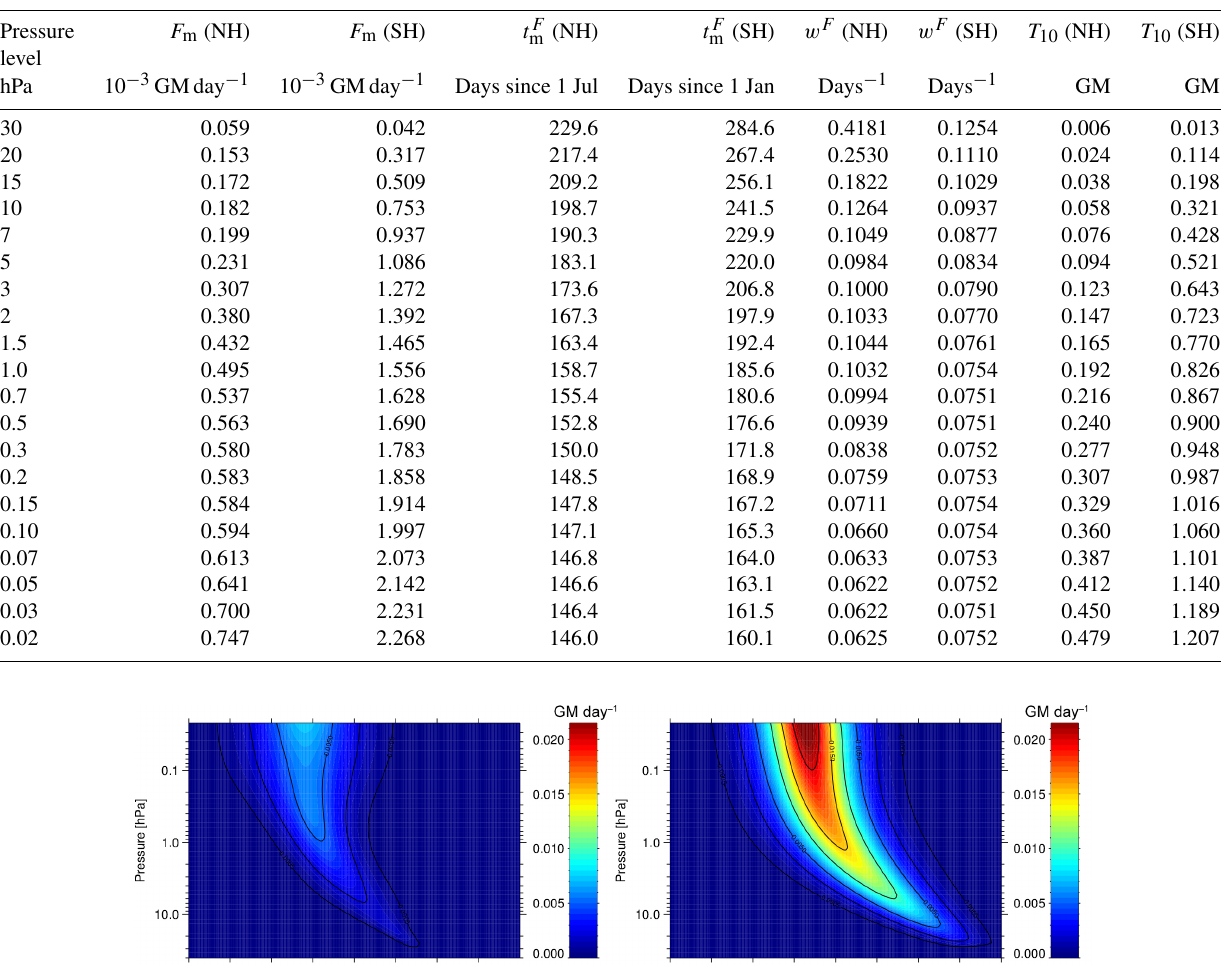
Table 2. Parameters F m , t F m , and w F of the empirical model for the vertical and temporal distributions of EPP-NO y fluxes (see Eq. 13) through a given pressure level in both hemispheres. The seasonally accumulated EPP-NO y amounts T 10 for a constant A p index of 10 (2002–2012 average) are also listed.